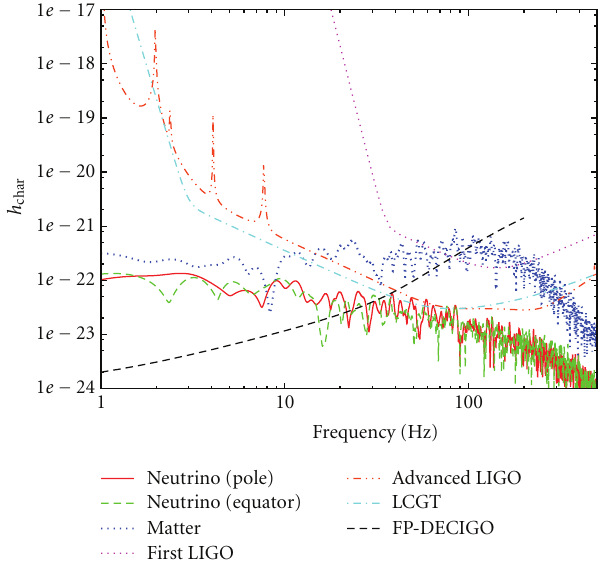
Figure 13: Spectral distributions of GWs from matter motions (“Matter”) and neutrino emission (“Neutrino”) seen from the pole or the equator for a representative 3D rotating model (e.g., [210]) with the expected detection limits of TAMA300 [12], first LIGO and advanced LIGO [215], Large-scale Cryogenic Gravitational wave Telescope (LCGT) [216] and Fabry-Perot type DECIGO [217]. It is noted that h char is the characteristic gravitational wave strain defined in [218]. The distance to the supernova is assumed to be 10 kpc. Note that for the matter signal, the + mode seen from the polar direction is plotted (from